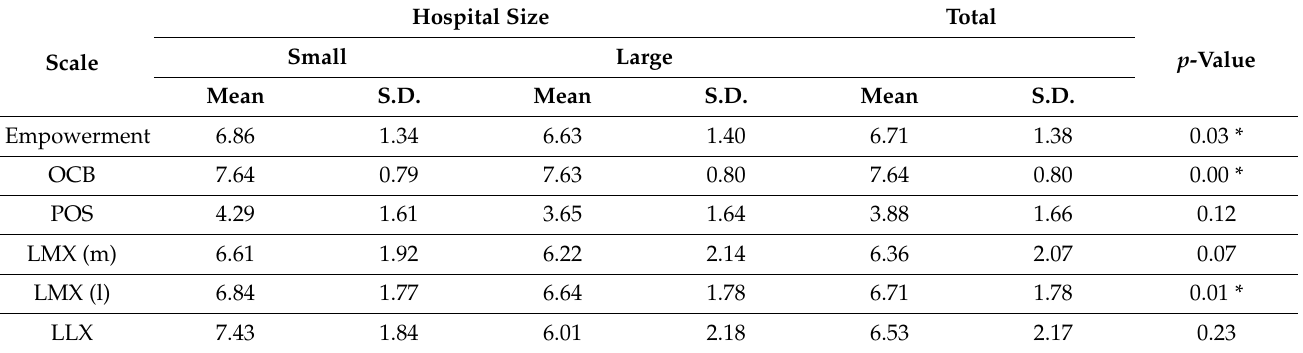
Table 2. Description of the questionnaires’ descriptive statistics by hospital size (range